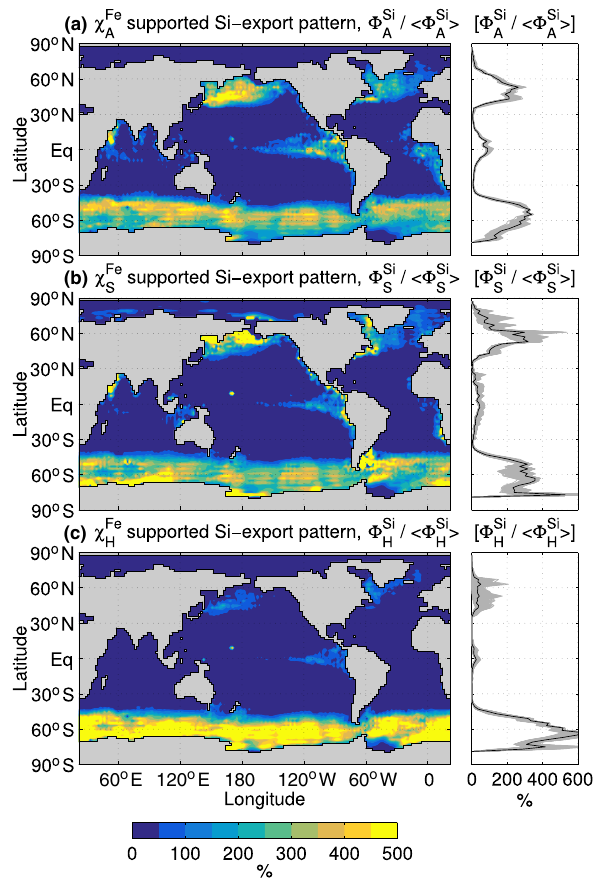
Figure 9. Opal export supported by each iron type [aeolian (a) , sed- imentary (b) , hydrothermal (c) ] normalized by its global mean. The map is for our typical state estimate, while zonal averages of the normalized opal export are shown for each family member in grey, with the typical state estimate in